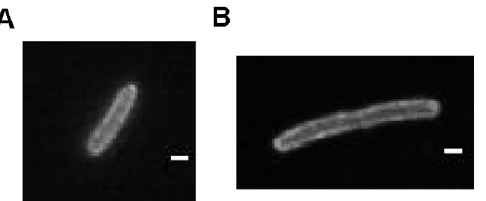
Figure 1. TetA-YFP fluorescence. Fluorescence images of cells expressing TetA-YFP. (A) A cell growing in minimal glucose medium. (B) A cell grown with cephalexin, causing filamentation, in order to perform FRAP measurements (see Methods). The scale bars indicate 1 m m.